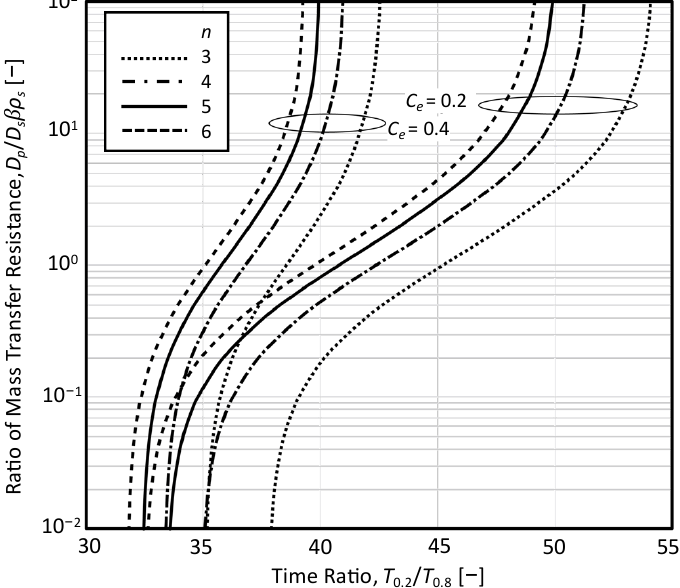
Figure 5. Dependency of mass transfer resistance ratio on the time ratio, T 0 . 2 / T 0 . 8